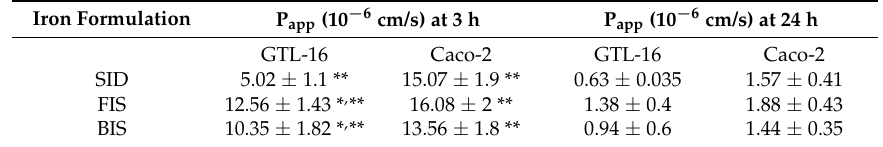
SID = Sideral ® ; FIS = Fisioeme ® ; BIS = iron bisglycinate. * p < 0.05 vs. SID; ** p < 0.05 between the same treatment at different